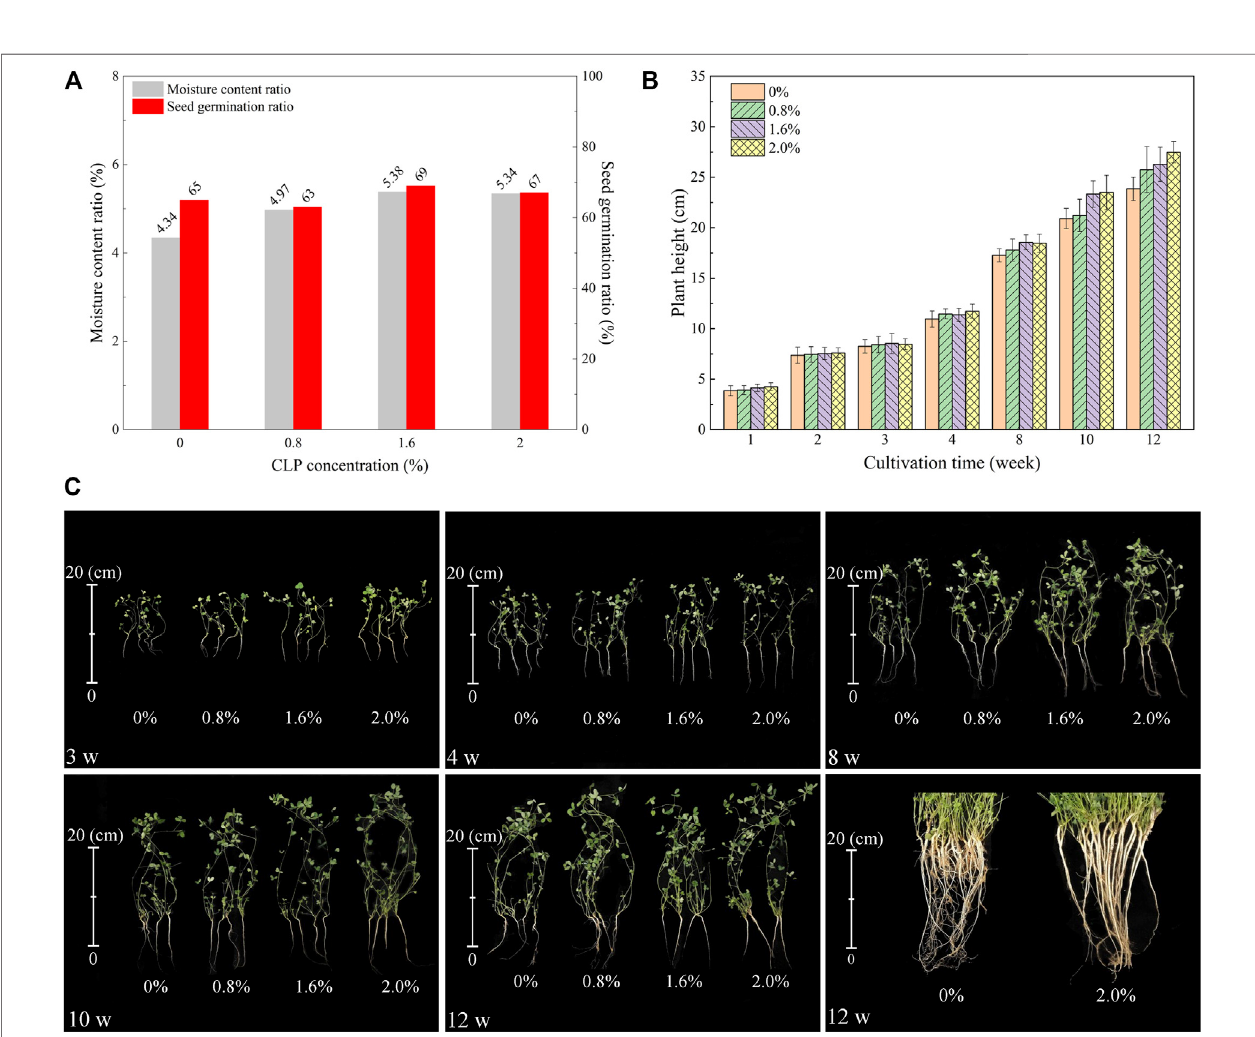
FIGURE 8 | (A) Water content ratio of potted loess treated with different cross-linked polymer (CLP) concentrations after drought stress, and its seed germination ratio 3 days after sowing. (B) Plant height of potted plants treated with different cross-linked polymer concentrations over time. (C) Potted plants treated with different cross-linked polymer (CLP) concentrations over